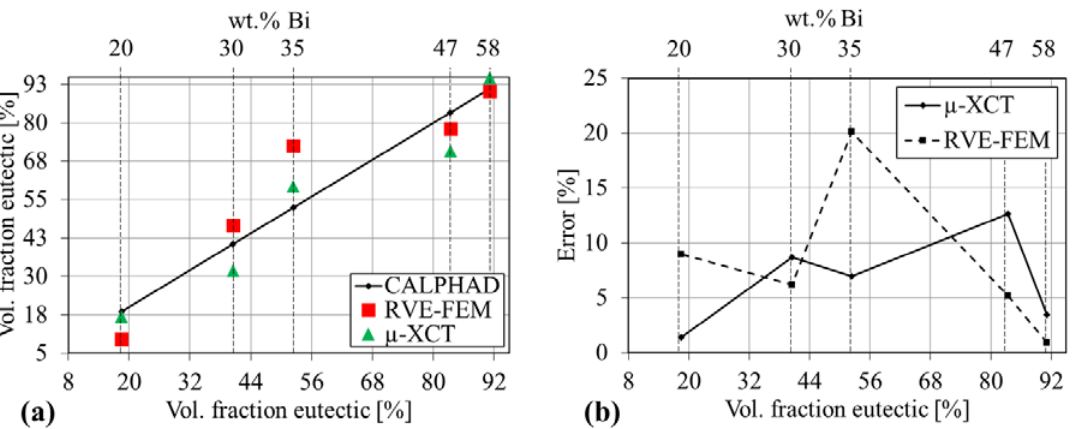
Figure 5. Eutectic volume fraction obtained from CALPHAD calculations, image analysis of µ -XCT data and the RVE- FE model. ( a ) eutectic volume fraction over composition ( b ) relative error of µ -XCT data and RVE-FE model based on equilibrium CALPHAD calculations over composition.